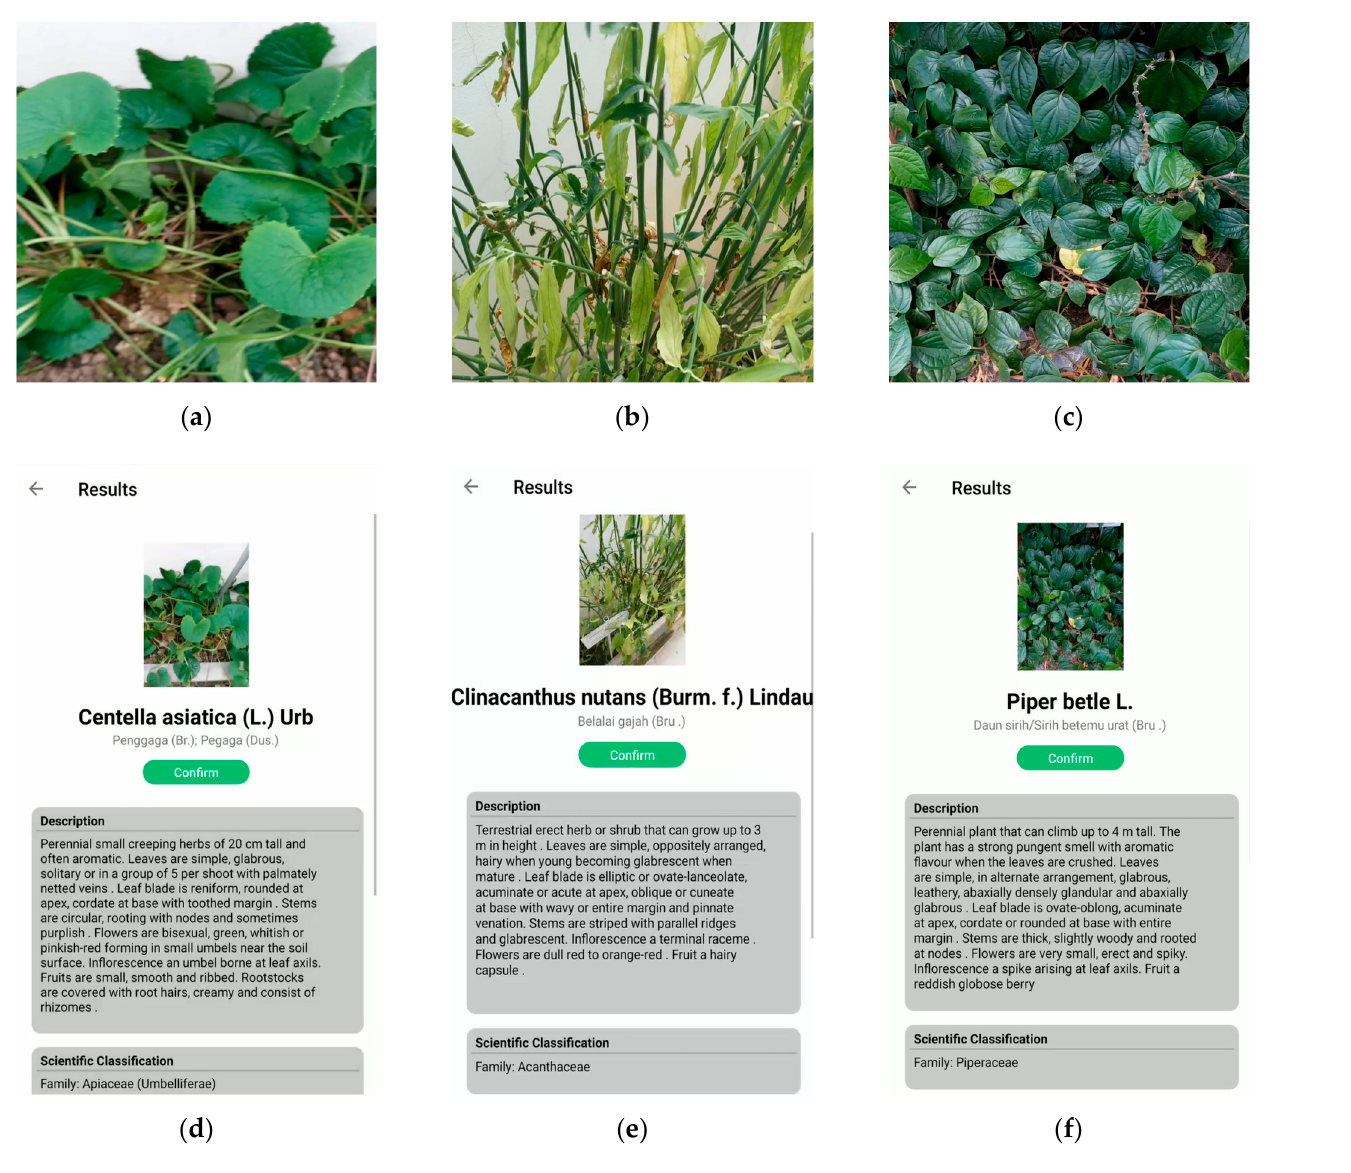
Figure 7. Examples of real-time classification of some species, using the mobile application: ( a ) Centella asiatica (L.) Urb; ( b ) Clinacanthus nutans (Burm. f.) Lindau; ( c ) Piper betle L.; ( d ) real-time classification of Centella asiatica (L.) Urb; ( e ) real-time classification of Clinacanthus nutans (Burm. f.) Lindau; ( f ) real-time classification of Piper betle L.